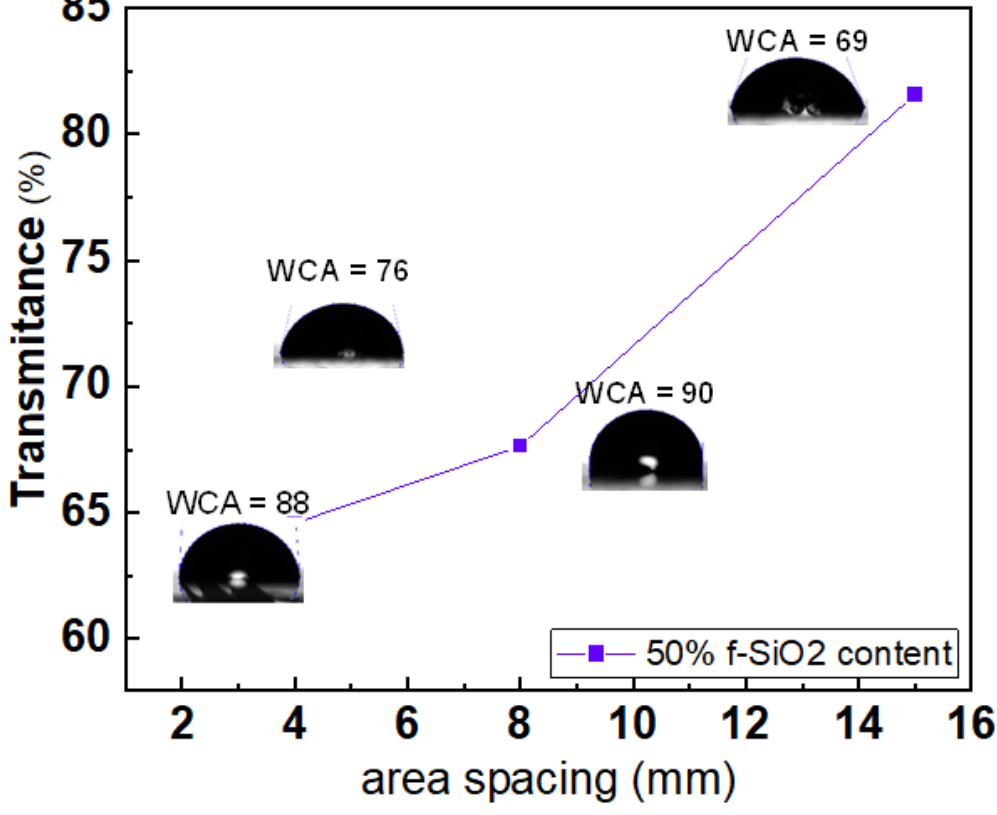
Figure 12. Value of average transmittance of the coating varies with the area spacing in mm with the corresponding WCA images and values. corresponding WCA images and